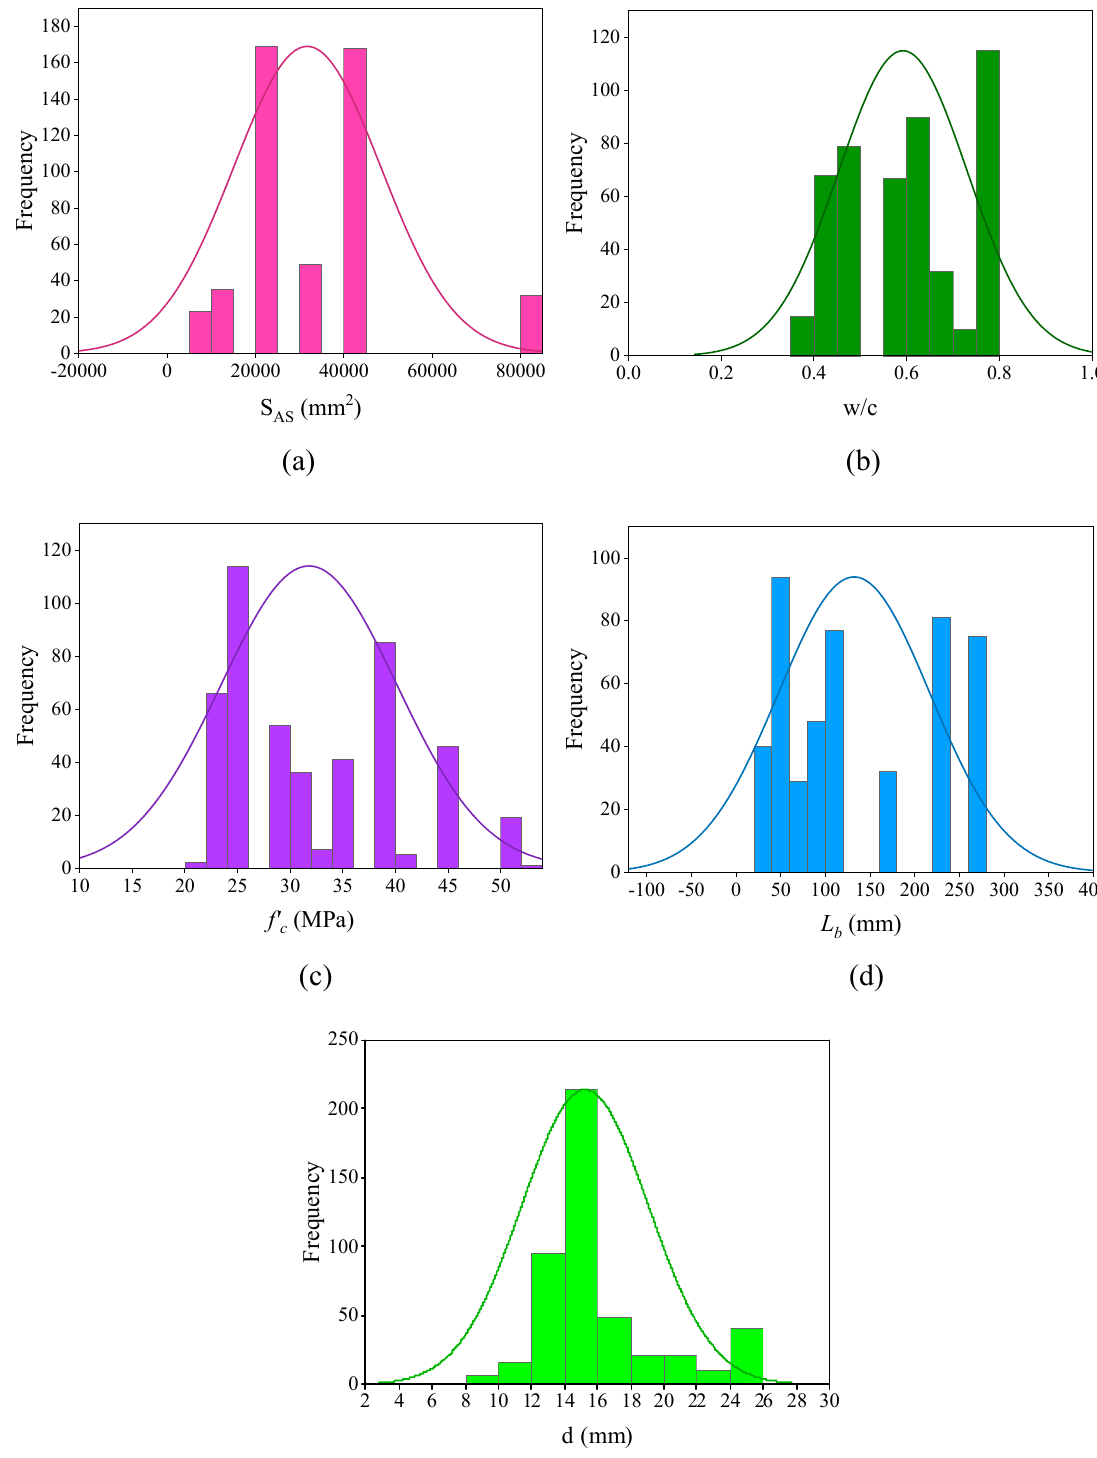
Figure 2. Relative frequency distribution of input and output parameters; ( a ) S AS , ( b ) w/c , ( c ) f (cid:48) c , ( d ) L b , ( e ) d , ( f ) T b , ( g ) f y , ( h ) c , ( i ) η , ( j ) τ u